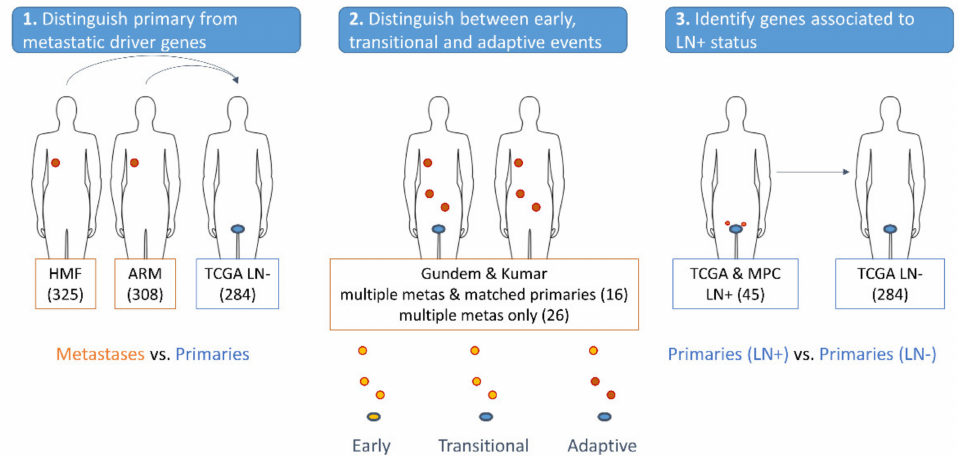
Figure 1. Validation of genes identified by GoNetic. Panel 1 . First, we compared the mutation rate of genes prioritized by GoNetic between each of the metastatic cohorts (HMF and ARM) and the primary cohort (TCGA). Mutational enrichment signal in metastatic samples is divided into three categories: strong, intermediate, and weak. Panel 2 . Secondly, we assessed whether GoNetic drivers could be associated with tumor evolution using cohorts of matching primary and metastatic samples. Genes reported by GoNetic were defined as primary/early drivers, transitional drivers, and late/adaptive drivers. Panel 3 . Lastly, we assessed whether mutations in any of the genes prioritized by GoNetic could be associated with the lymph node-positive status of the